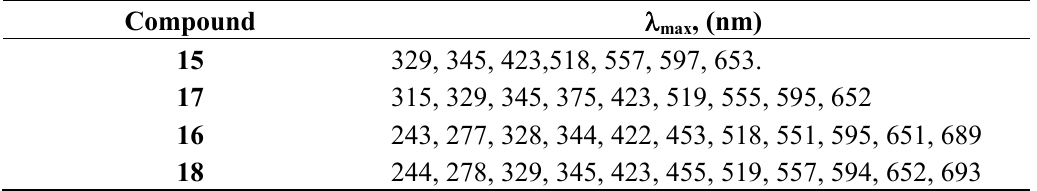
)  of dendrimers 15 – 18 max